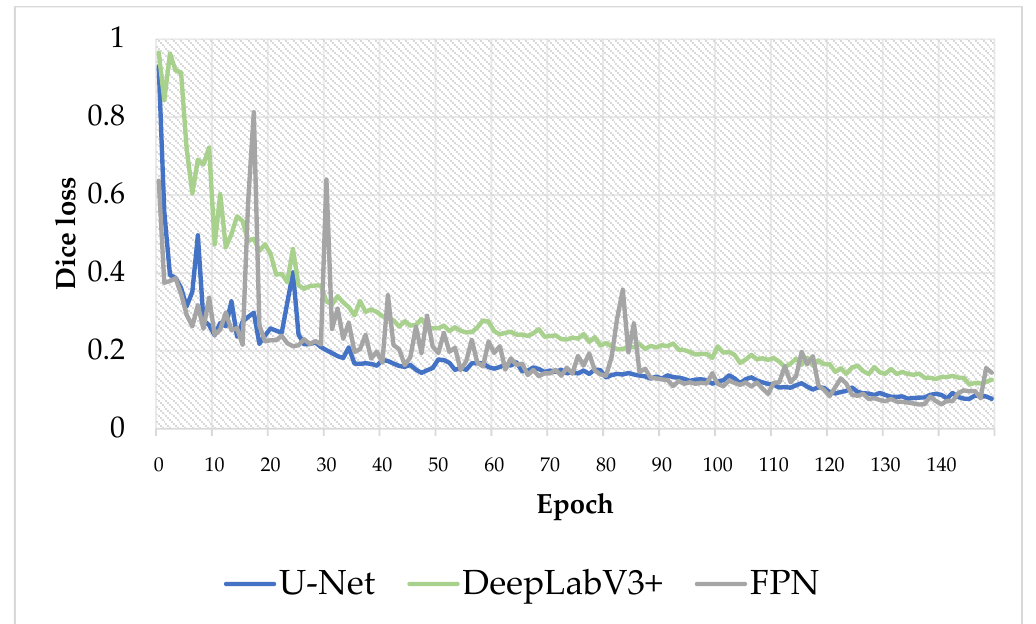
Figure 7. Segmentation models` performance evaluation results.